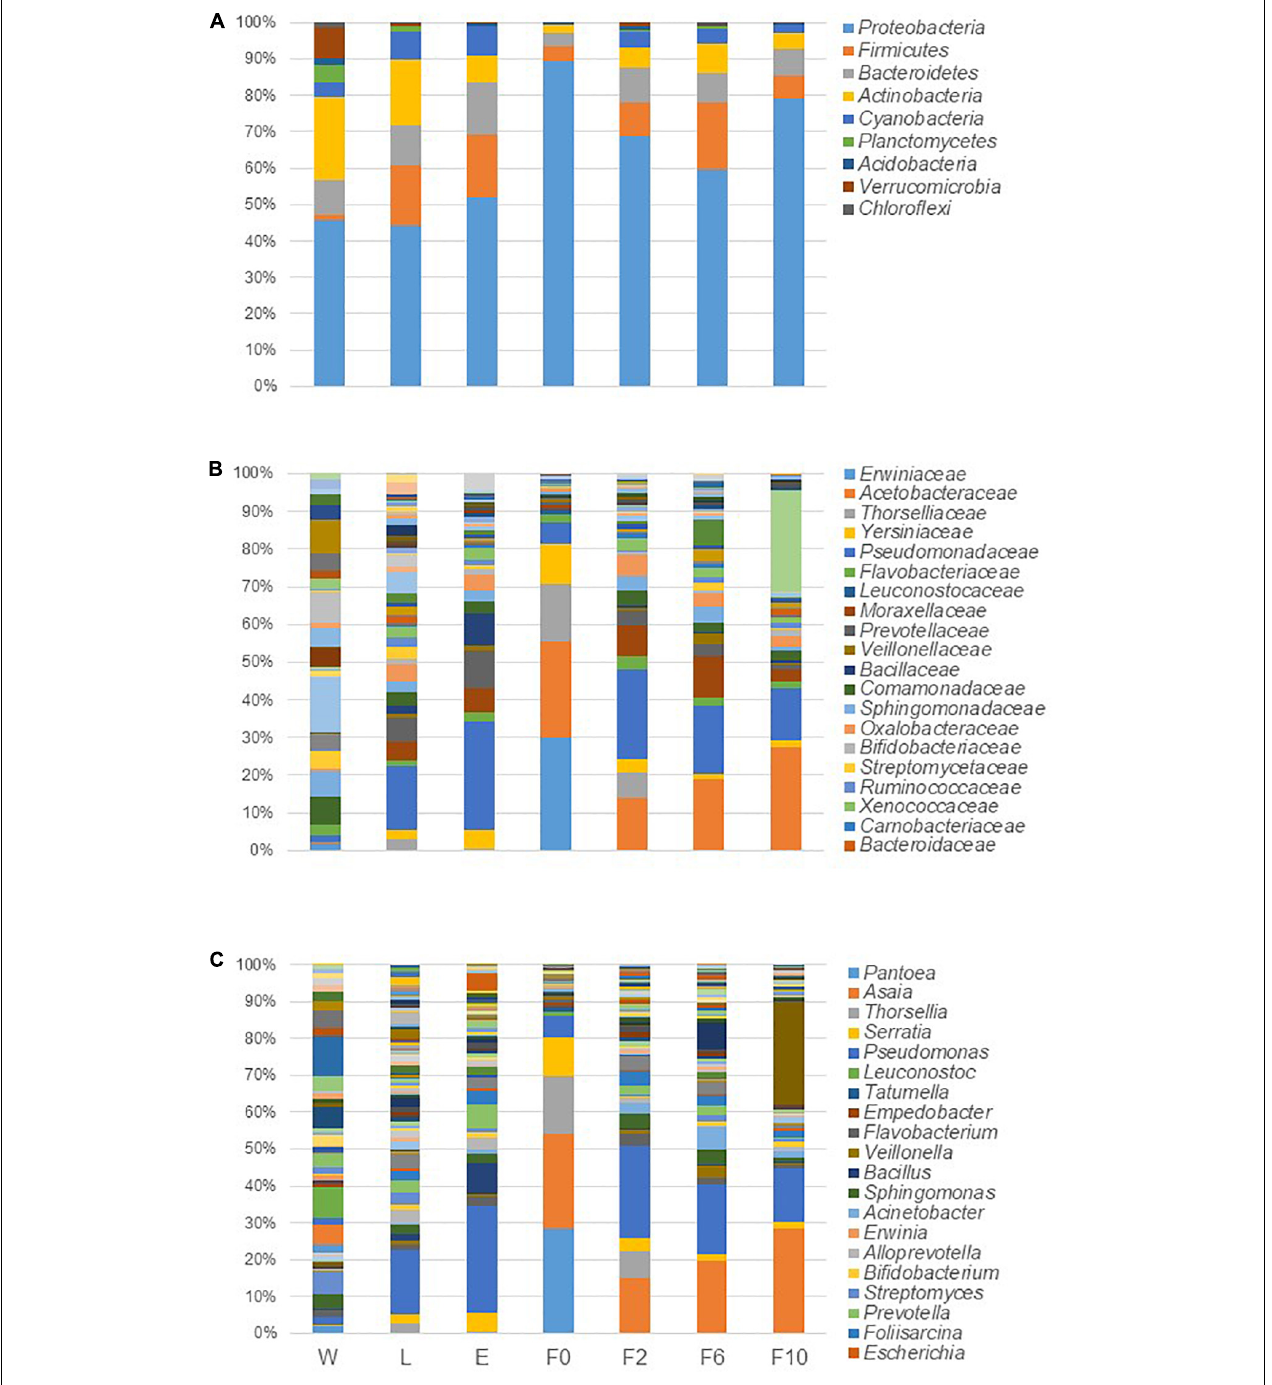
FIGURE 3 | Microbiota composition in breeding water and in sylvan and laboratory-reared An. atroparvus at phylum (A) , family (B) , and genus (C) levels. The average of the relative abundances per bacterium from three pools per sample type is represented in bars, and the top 20 taxa are shown.